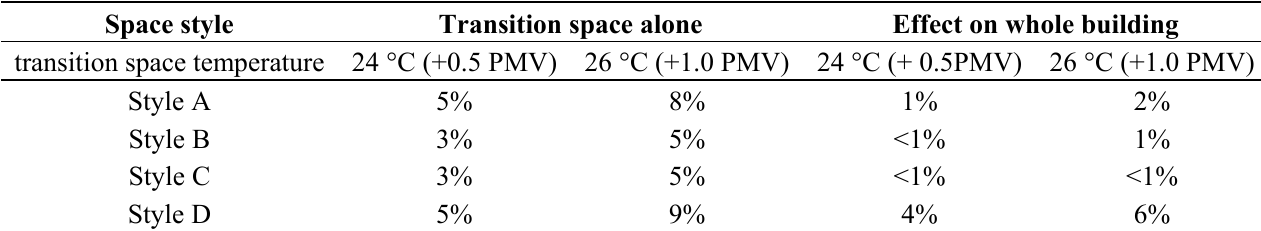
Table 8. Reductions in annual cooling energy use for transition zone study (data adapted from